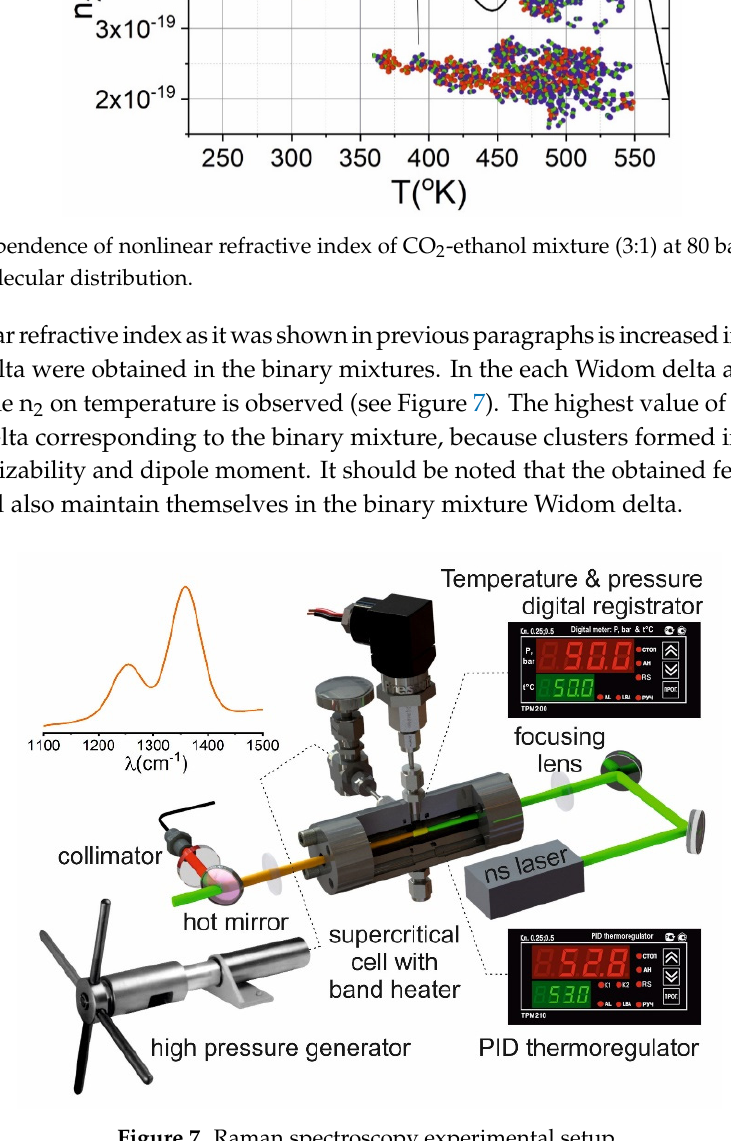
Figure 7. Raman spectroscopy experimental setup.